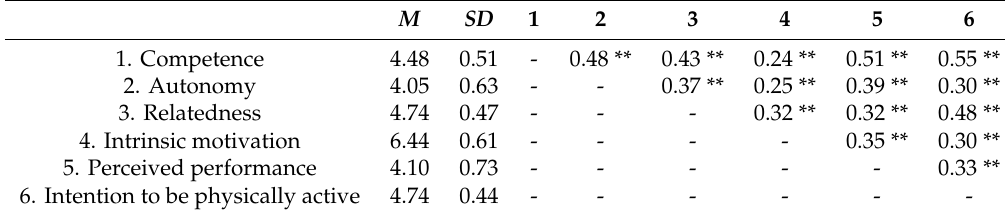
Table 3. Descriptive statistics and bivariate